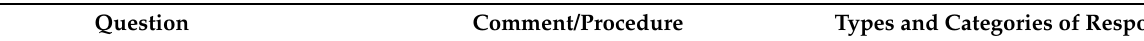
Table 1. Structured interview: Questions asked and categories of responses. All garden owners were interviewed by the same person (B.Br.). Garden owners were familiar with the interviewer due to the repeated visits for the biodiversity survey in the previous